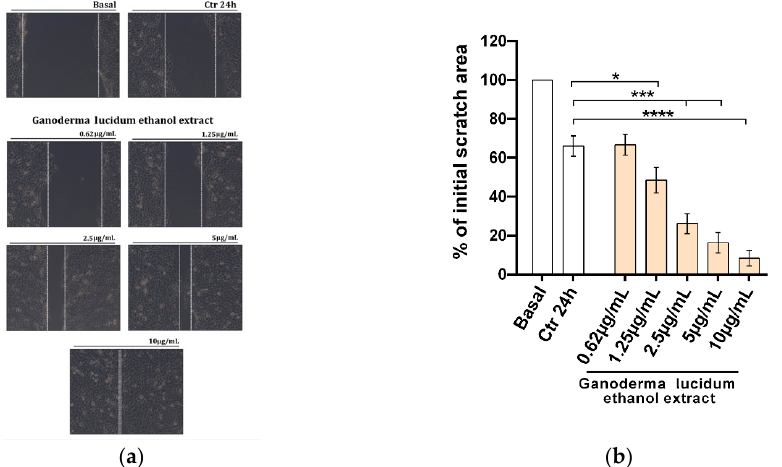
Figure 3. Improvement of the migratory capacity of human keratinocytes exposed to the G. lucidum extract: ( a ) wound healing assay performed in HaCaT cells treated for 24 h with vehicle (CTR) or G. lucidum extracts at the indicated concentrations (0.62–10 µg mL − 1 ) in complete medium. Representative light microscope images from three independent experiments are shown. Dotted white lines indicate the wounded area from the initial scratch. Magnification is at ×20. ( b ) Histograms represent the mean scratch area observed in HaCaT cells expressed as a percent of the initial area. The measurement was made in three different experiments. The results are presented as mean ± standard error (ANOVA, * p < 0.05, ** p < 0.01, *** p < 0.001 and **** p < 0.0001 vs. control).